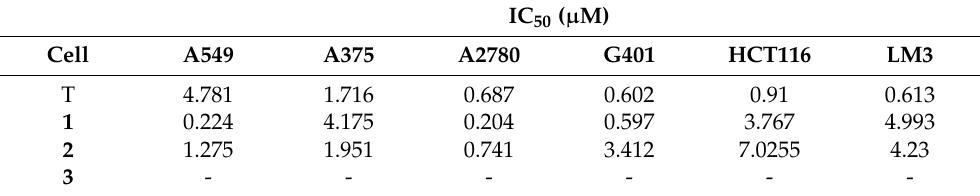
Figure 6. Effects of toluquinol-derived metabolites 1 – 3 and toluquinol on human tumor cell lines including non-small-cell lung cancer cell A549, skin melanoma cell A375, ovarian cancer cell A2780, kidney tumor cell G401, colorectal cancer cell HCT116, and hepatocellular carcinoma LM3. Table 1. IC 50 values for toluquinol-derived metabolites 1 – 3 towards human tumor cell lines.